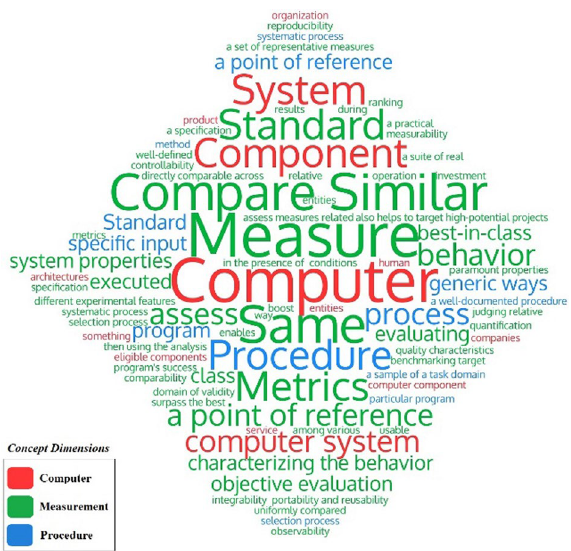
Fig. 1 A segmented word cloud showing the emphasis on different concepts in definitions of